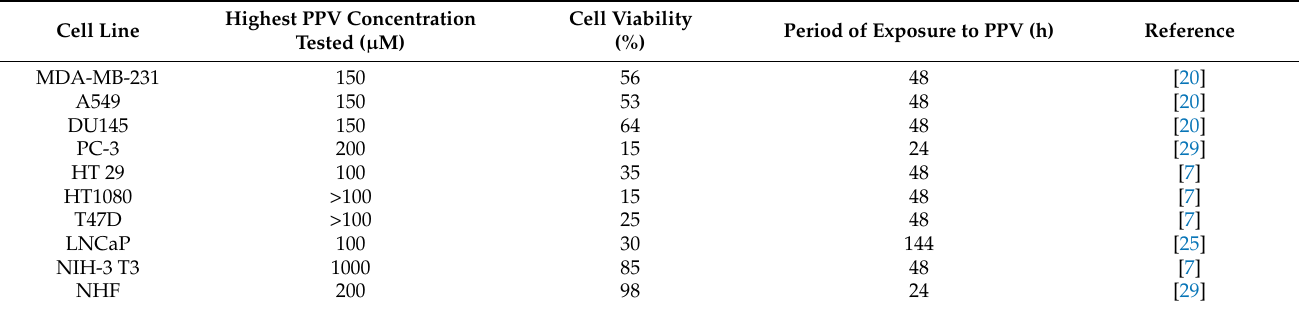
Table 2. A summary of the maximal antiproliferative effects exerted by various concentrations of PPV resulting in cell viability in tumorigenic and non-tumorigenic